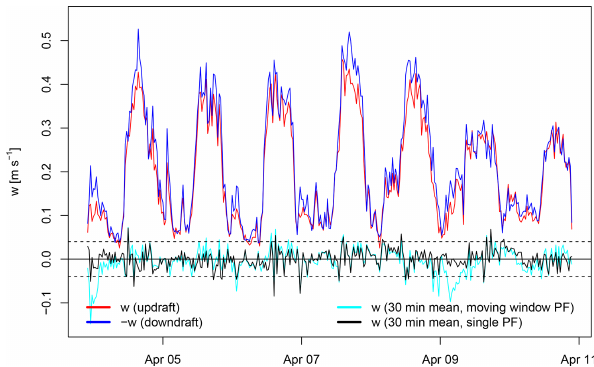
Figure 13. Vertical wind velocity of updrafts and downdrafts, in red and blue, respectively, averaged to 30min resolution and shown as absolute values. Vertical velocity is subject to a 1d running win- dow real-time planar fit coordinate rotation as obtained from the TEA system. Mean vertical wind velocity at 30min resolution af- ter running window real-time planar fit coordinate rotation, in blue, and after a post-processing planar fit coordinate rotation with the fit period corresponding to the full period shown, in black. Note that updrafts (red) and downdrafts (blue) shown here are different from | w | used for flux calculation according to Eq. (7).